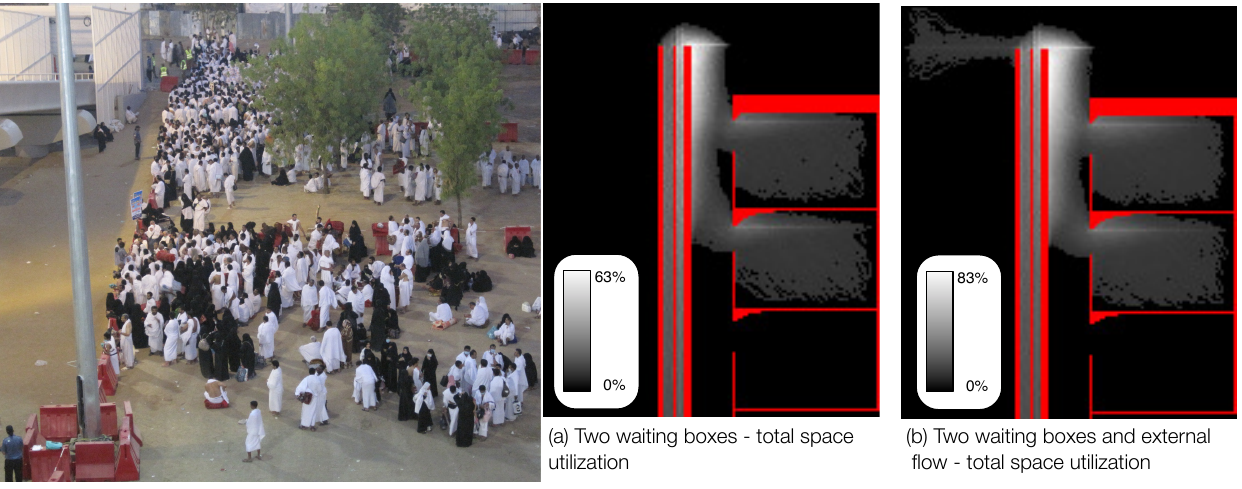
Figure 7. A portion of a simulated scenario on the left and two schematic representations of the level of space utilisation on the right.